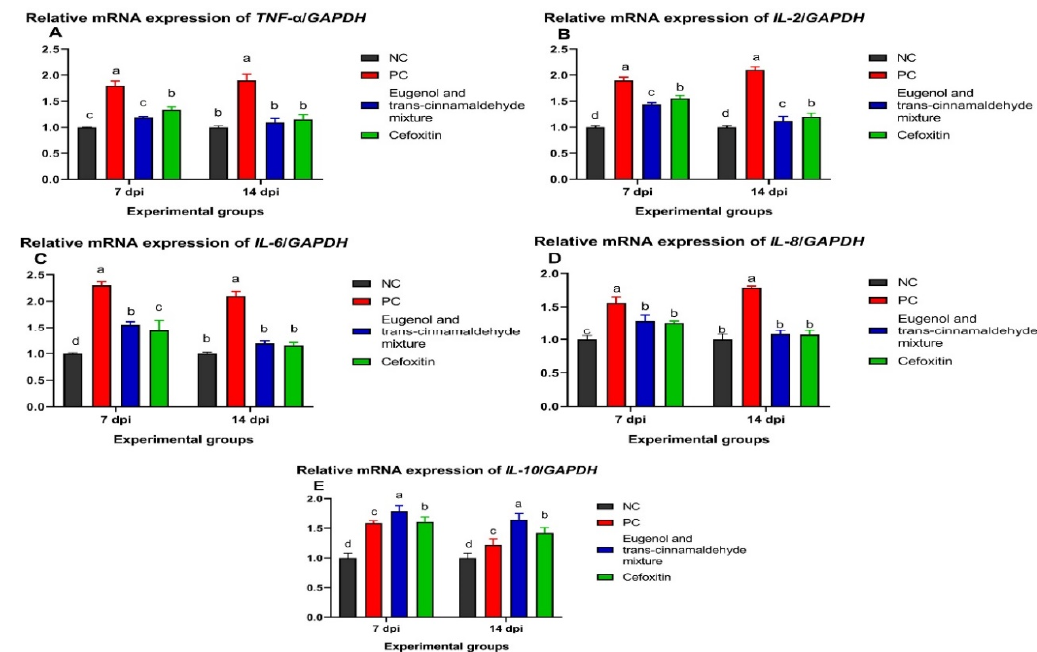
Figure 5. Relative mRNA expression levels of tumor necrosis factor-alpha ( TNF- α ; ( A )); interleukin-2 ( IL-2 ; ( B )); IL-6 ( C ), IL-8 ( D ), and IL-10 ( E ) in the spleen of chicks supplemented with the mixture of eugenol and trans-cinnamaldehyde and treated with cefoxitin antibiotic at 7 and 14 days post- infection (dpi) with XDR C. jejuni . Error bars represent the standard error of the mean (SEM). NC (negative control): chicks fed a basal diet and not challenged; PC (positive control): chicks fed a basal diet and challenged with XDR C. jejuni ; eugenol and trans-cinnamaldehyde mixture: chicks fed the basal diet supplemented with a mixture of eugenol and trans-cinnamaldehyde; and cefoxitin: chicks fed a basal diet and treated with a cefoxitin antibiotic. All groups, except the NC group, were challenged with XDR C. jejuni at 23 days of age. a–d Means of the columns with different letters indicate a statistically significant difference ( p <